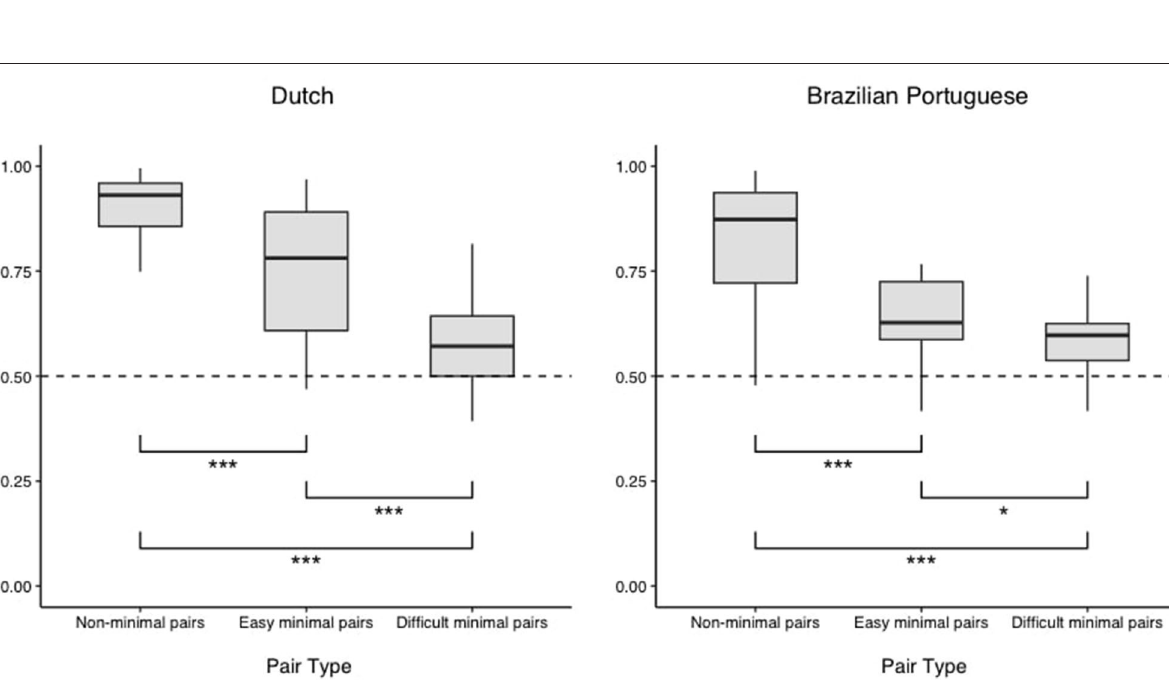
Frontiers in Communication |